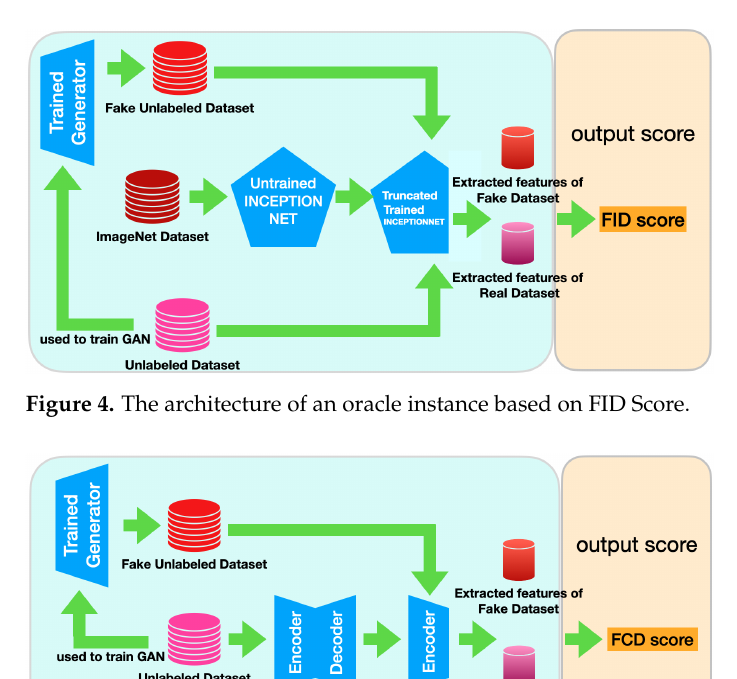
Figure 3. The architecture of the oracle based on IS.